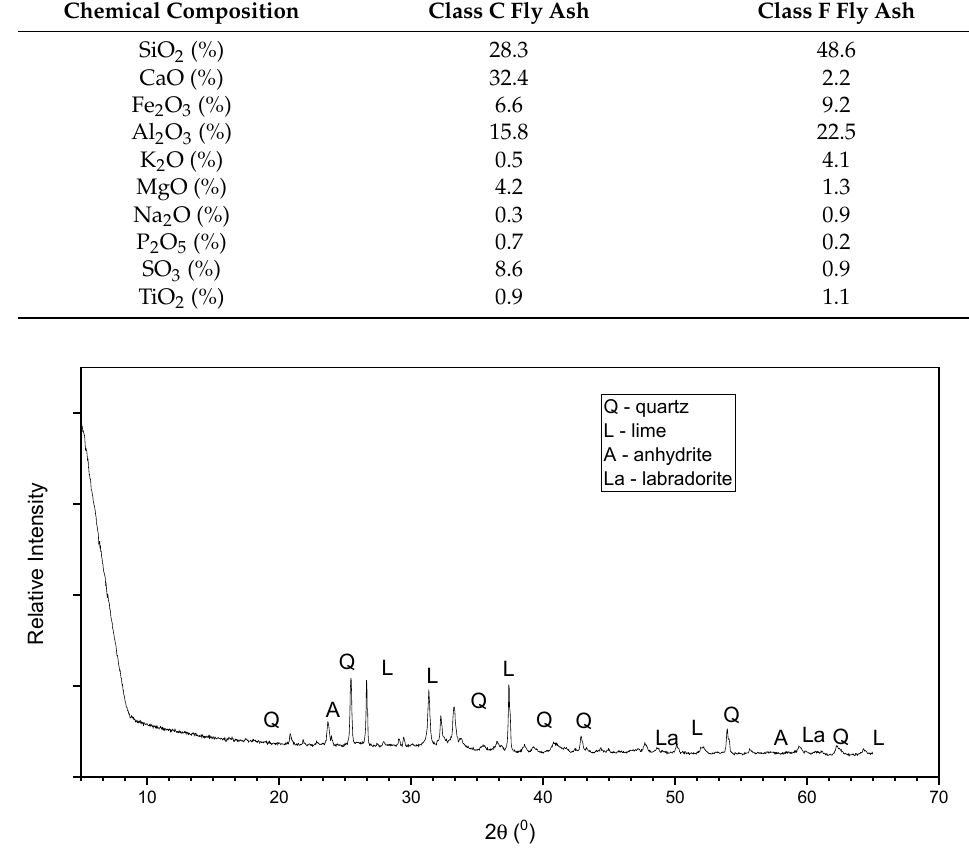
Figure 3. X-ray diffraction (XRD) pattern of class C fly ash.